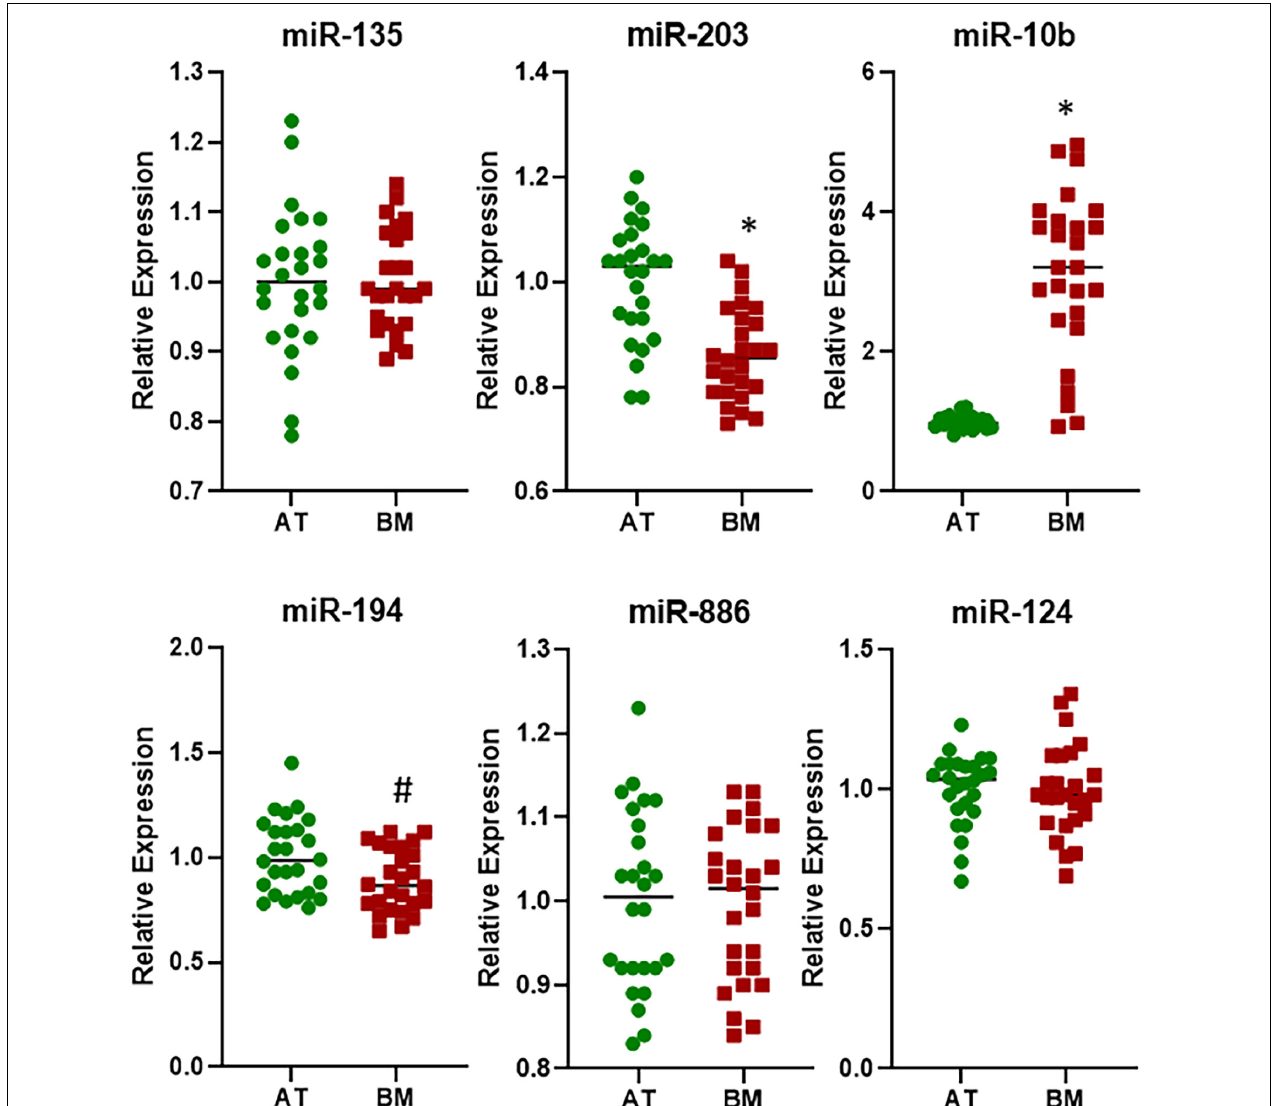
FIGURE 3 | Differential expression of miRNAs in breast cancer cohort. miRNAs were evaluated by qRT-PCR for their expression levels in BM from patients with primary breast cancer, relative to their expression in the AT. ∗ p < 0.01; # p <